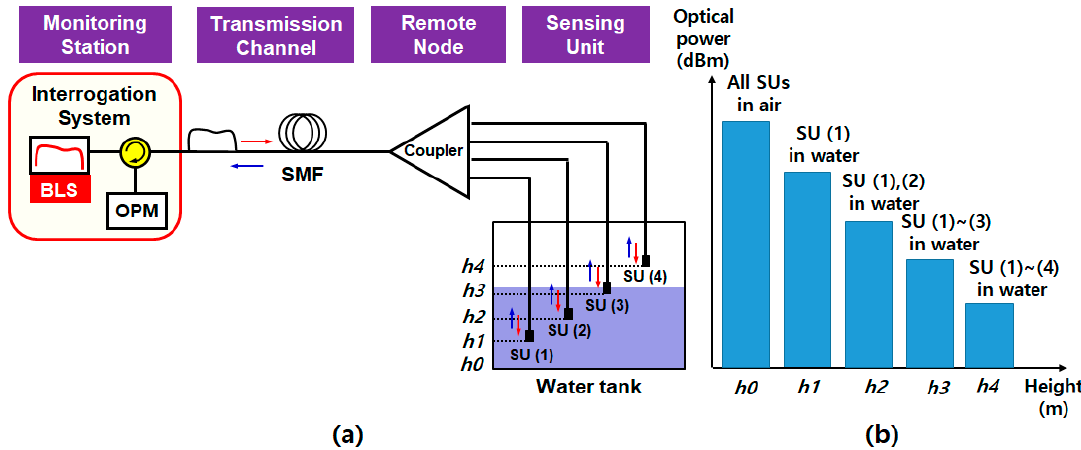
Figure 5. ( a ) Schematic diagram of the SDM-based water level monitoring system ( b ) Conceptual interrogation result according to water level. Adapted from Noor et al. [41]. BLS: broadband light source, OPM: optical power meter, SMF: single mode fiber, SU: sensing unit, and h 0– h 4: height of the